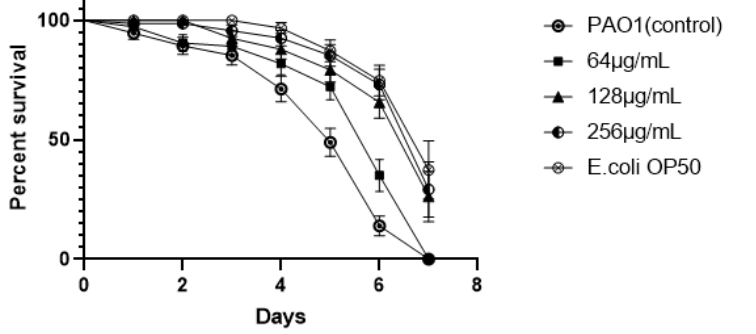
Figure 13. EGCG increased the survival rate of C. elegans infected with P. aeruginosa. (All data are representative of three independent experiments performed in triplicate and expressed as the mean ± SD values in each bar.